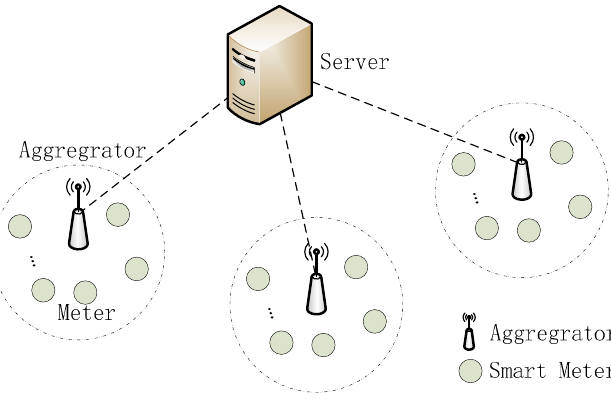
Figure 1. The structure of the model.